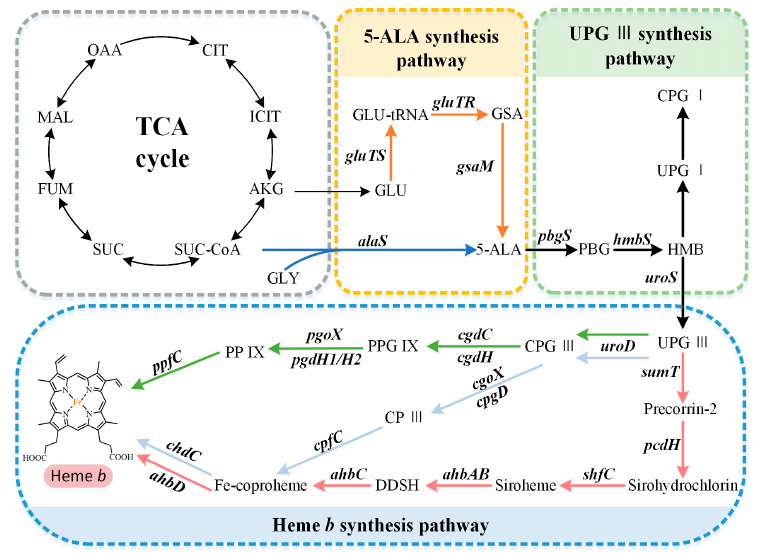
Figure 1. Heme b biosynthesis pathway. The overall biosynthetic pathway of heme b can be divided into three parts. The orange arrows indicate the C5 pathway, the blue arrows indicate the C4 pathway, the green arrows indicate the protoporphyrin-dependent (PPD) pathway, the light blue arrows indicate the coproporphyrin-dependent (CPD) pathway, and the red arrows indicate the siroheme-dependent (SHD) pathway. OAA, oxaloacetate; MAL, malate; FUM, fumarate; SUC, succi- nate; SUC-COA, succinyl-CoA; α -KG, α -oxoglutarate; GLY, glycine; GLU, glutamate; GLU-tRNA, glutamyl-tRNA; GSA, glutamate-1-semialdehyde; 5-ALA, 5-aminolevulinic acid; PBG, porphobilino- gen; HMB, hydroxymethylbilane; UPG I, uroporphyrinogen I; CPG I, coproporphyrinogen I; UPG III, uroporphyrinogen III; CPG III, coproporphyrinogen III; PPG IX, protoporphyrinogen IX; PP IX, protoporphyrin IX; CP III, coproporphyrin III; DDSH,